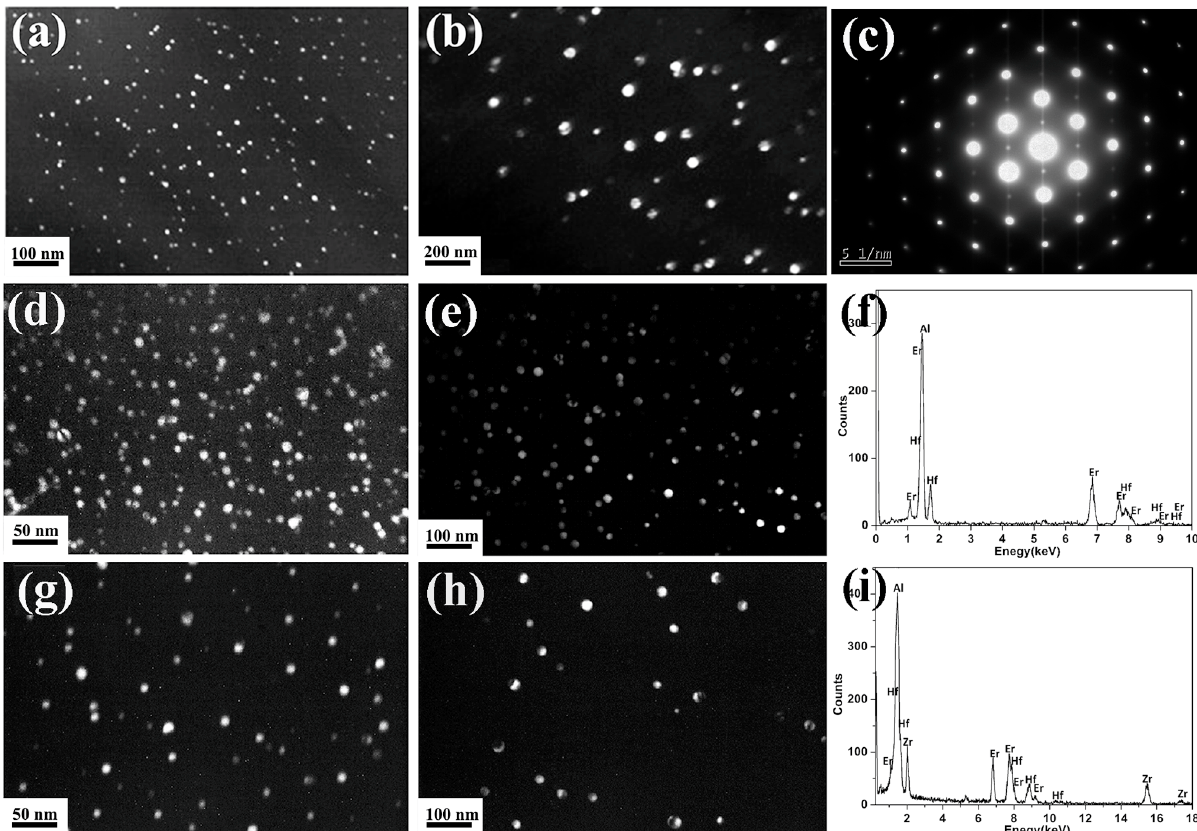
Figure 3. Dark-field TEM micrographs of precipitates: ( a , d , g ) Al-Er-Zr, Al-Er-Hf, and Al-Er-Zr-Hf alloy annealed at 450 °C for 100 h; ( b , e , h ) Al-Er-Zr, Al-Er-Hf, and Al-Er-Zr-Hf alloy annealed at 500 °C for 100 h after being annealed at 450 °C for 100 h; ( c ) the SAED pattern of precipitates; ( f , i ) EDX analysis of precipitates.